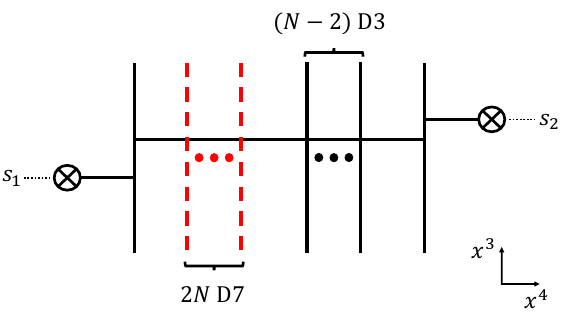
Figure 5 . A brane con(cid:12)guration for a product of two minimal ’t Hooft line operator with the magnetic charge B = (cid:0) e 1 + e N . A smooth monopole with magnetic charge e 1 (cid:0) e N is also introduced. s 1 ; 2 indicates the location of the NS5-branes in the x 3